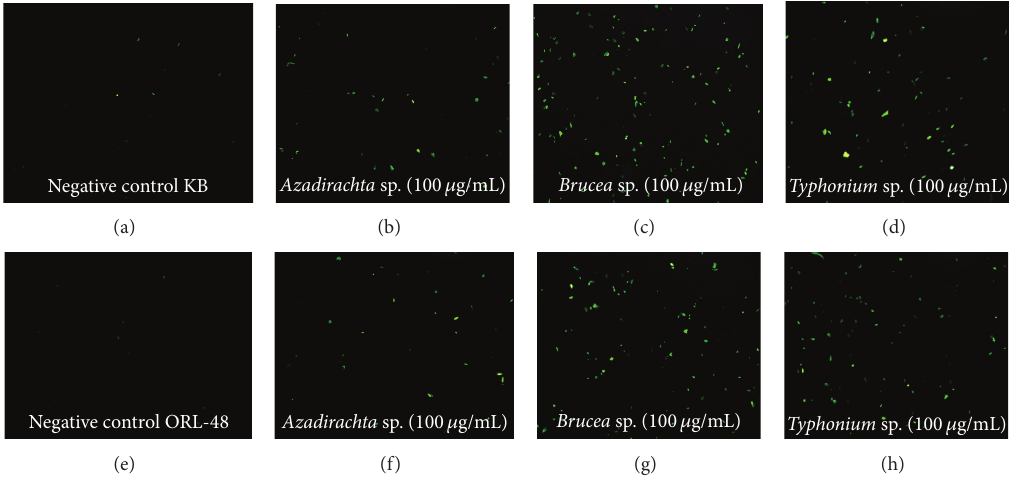
Figure 3: Images of fluorescent-stained KB and ORL-48 cells following treatments with 100 𝜇 g/mL of Azadirachta sp. ((b), (f)), Brucea sp. ((c), (g)), and Typhonium sp. ((d), (h)) at 10x magnification. (a) and (b) were the negative controls for KB and ORL-48 cells, respectively.